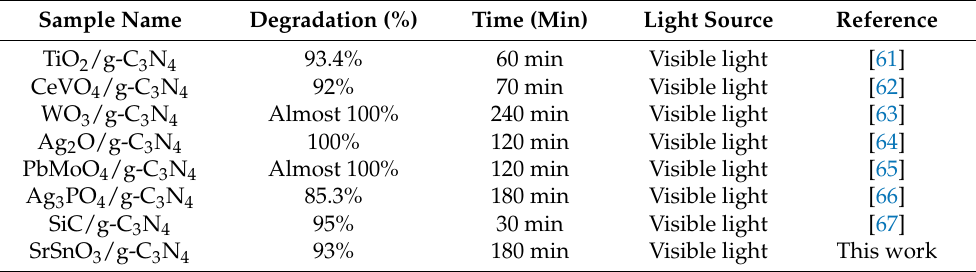
Figure 9. Reusability of photocatalytic activities experiment on 40SSO/CN photocatalyst.